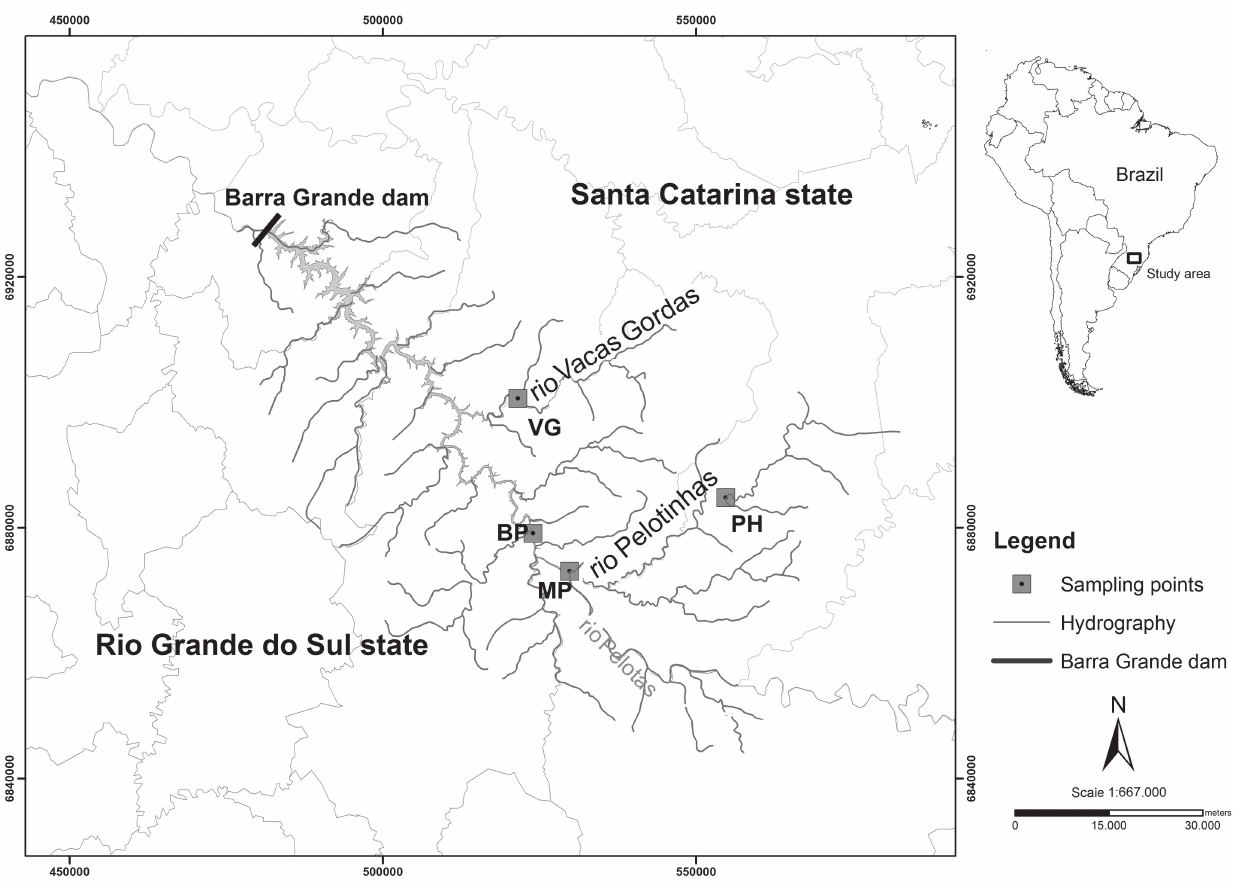
Fig. 1. Adult Rhamdia quelen sampling points location in the upper rio Uruguay. Geographical location of the points: rio Pelotinhas (PH: 28º09’41.1”S 50º26’34.3”W), mouth of rio Pelotinhas with rio Pelotas (MP: 28º30.0’32.1” S 50º56’40.9’’ W), rio Pelotas BP: 28º12.0’49.7’’S 50º45.0’22.6’’W) and rio Vacas Gordas (VG: 28º1.0’15.5’’S